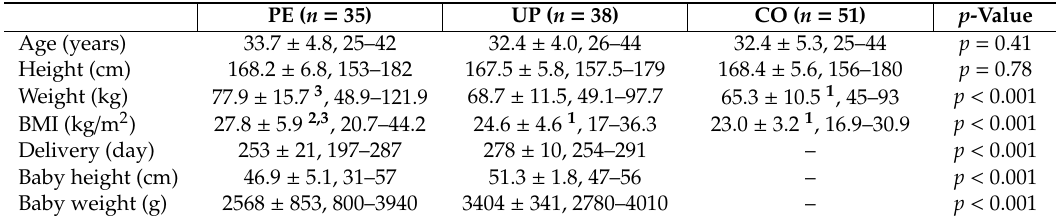
Table 5. Characteristics of the participants (mean ± SD, range), and statistical di ff erences. PE ( n =